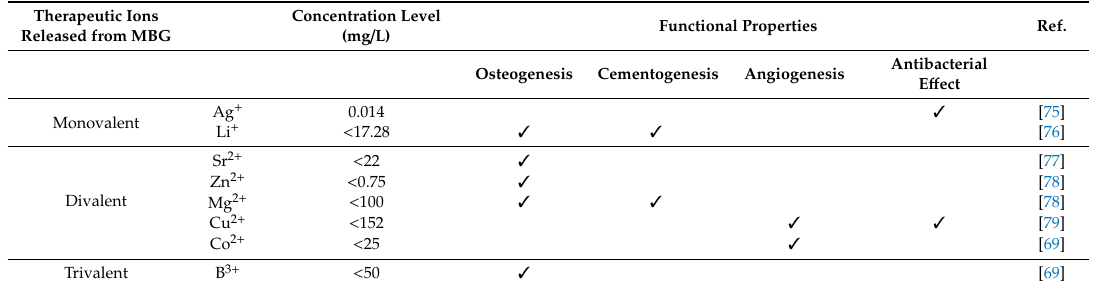
Table 4. Positive e ff ects associated to the release of therapeutic ions from MBGs and main properties. Therapeutic Ions Released from